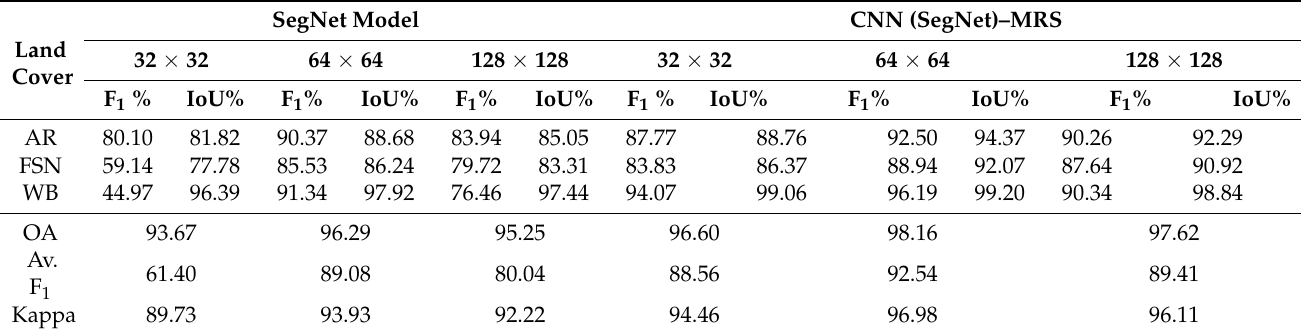
Table 13. Kocaeli test site with 7 bands: performance metrics with